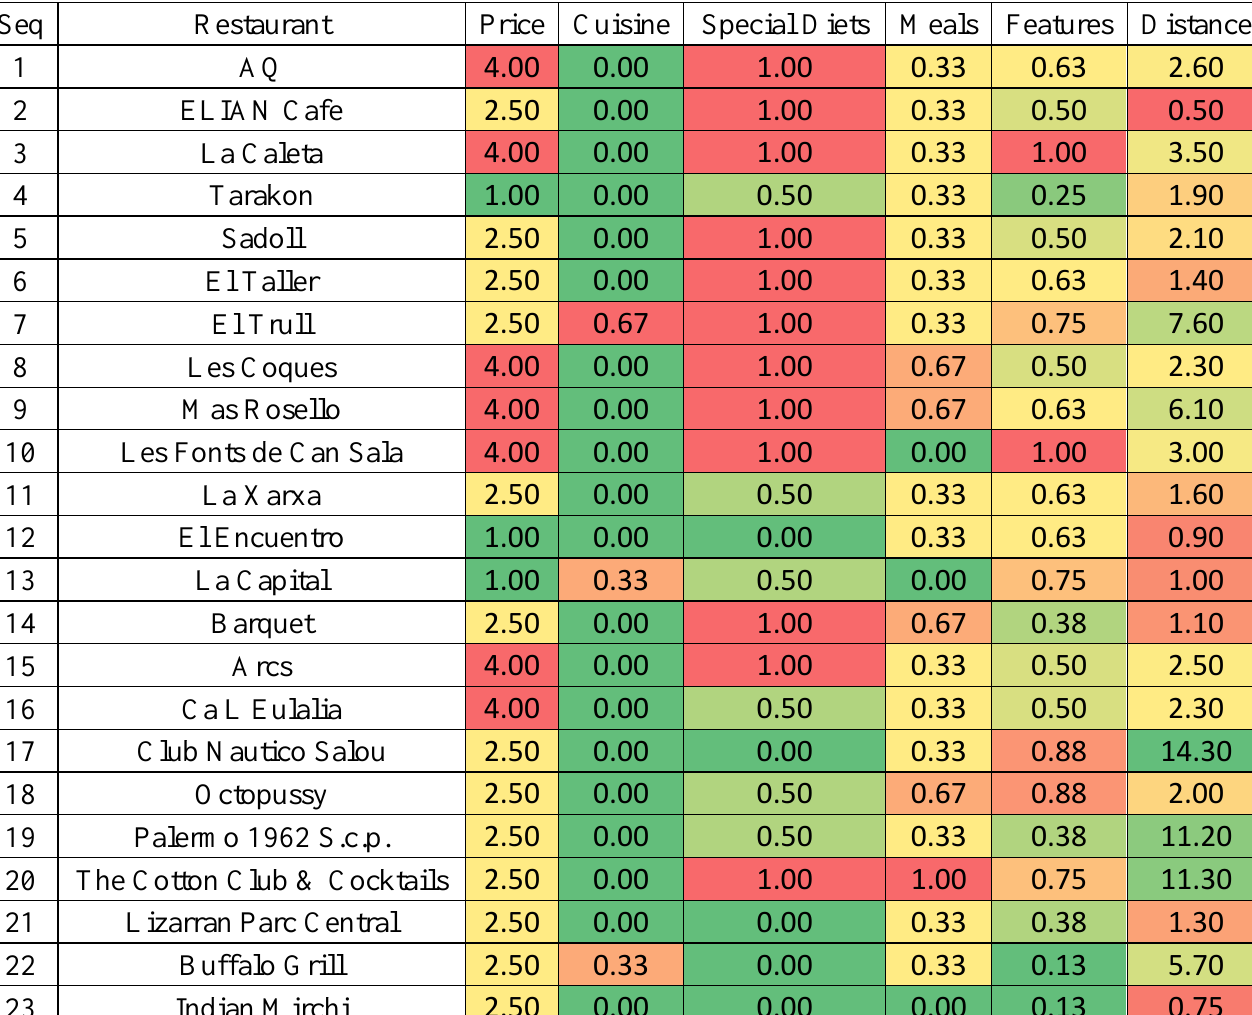
Figure 10. Profile 2: the domain performance-table. The colour indicates the degree of satisfaction, and colours range from green, the worst, to red, the